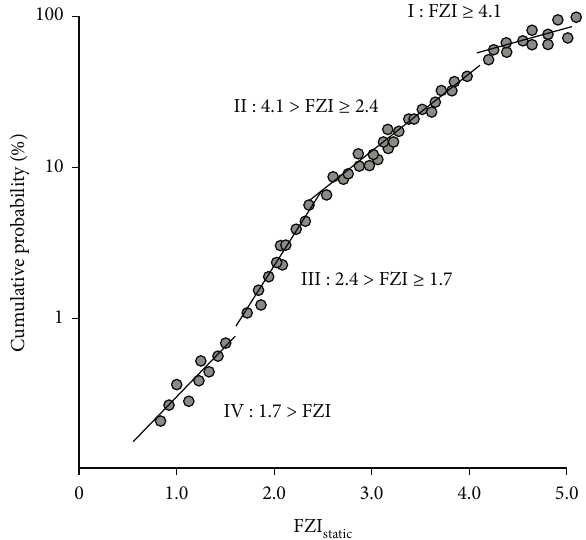
Figure 2: FZI static cumulative probability